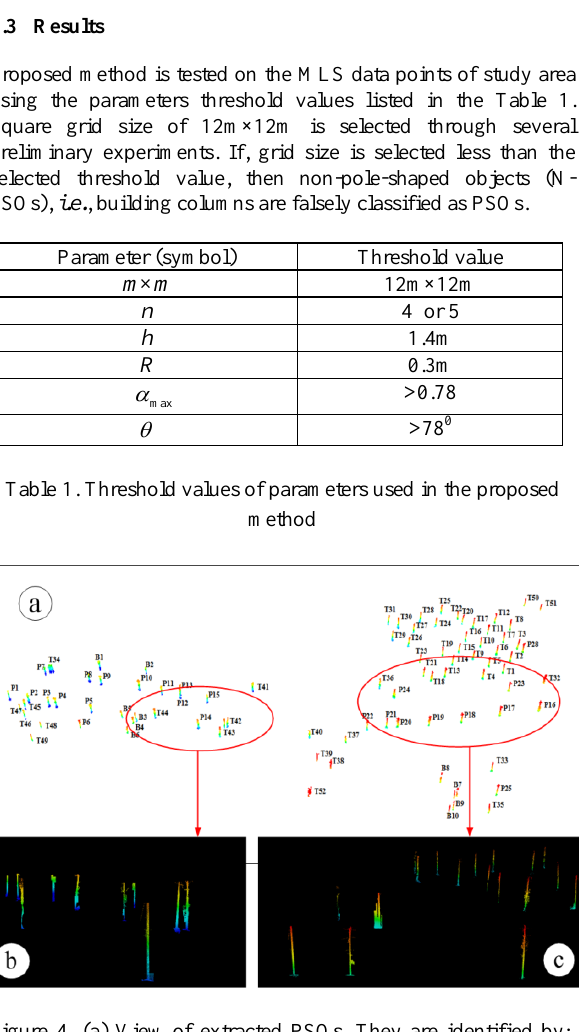
Figure 4. (a) View of extracted PSOs. They are identified by: symbol T used for tree, P for pole by considering reference data. Symbol B is used for extracted building columns; (b) & (c) Zoomed in view of PSOs from two locations of MLS data points of study area